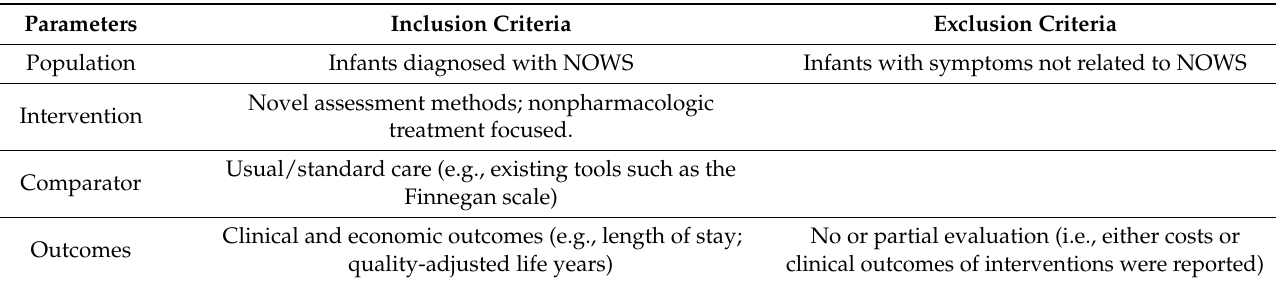
Table 1. PICO criteria for inclusion and exclusion of